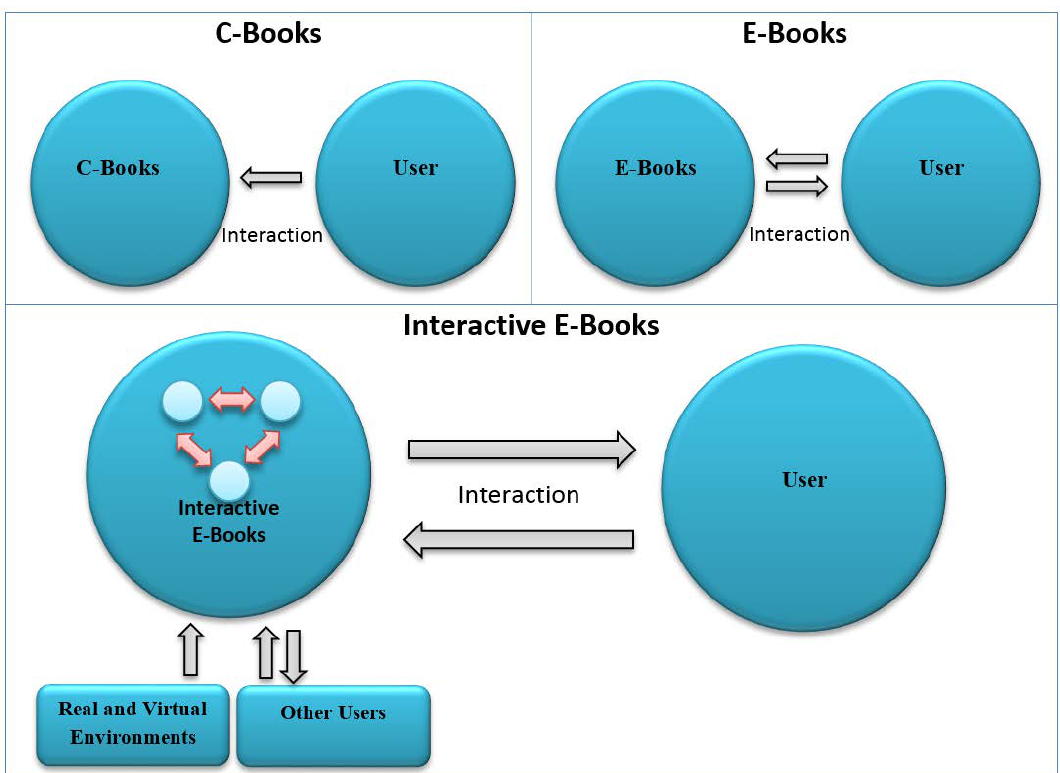
Figure 1. Comparison of c-books, e-books and interactive e-books (Bozkurt & Bozkaya, 2013a; 2013b)